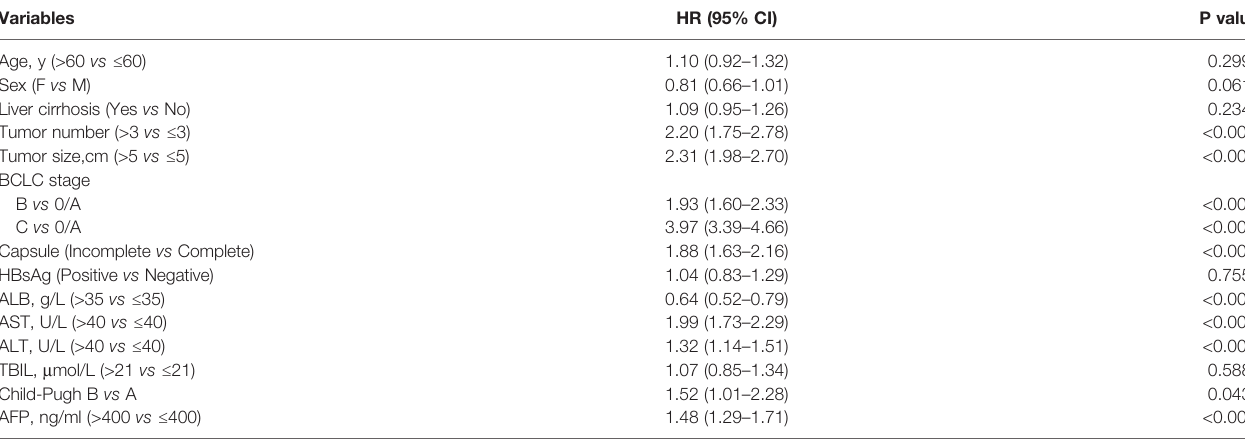
TABLE 2 | Risk of mortality associated with serum prealbumin*.